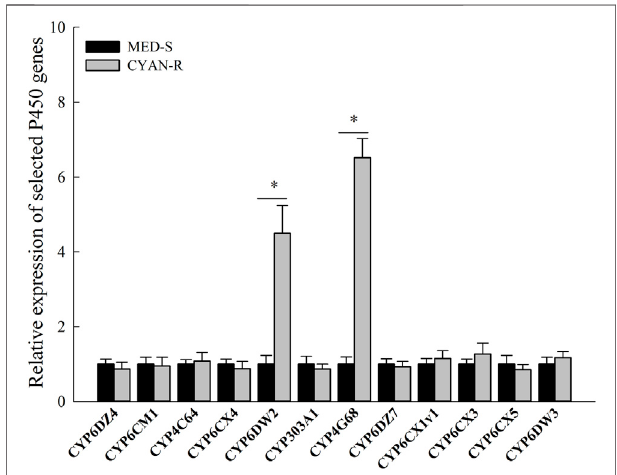
FIGURE 1 | Expression pro fi les of 12 candidate P450